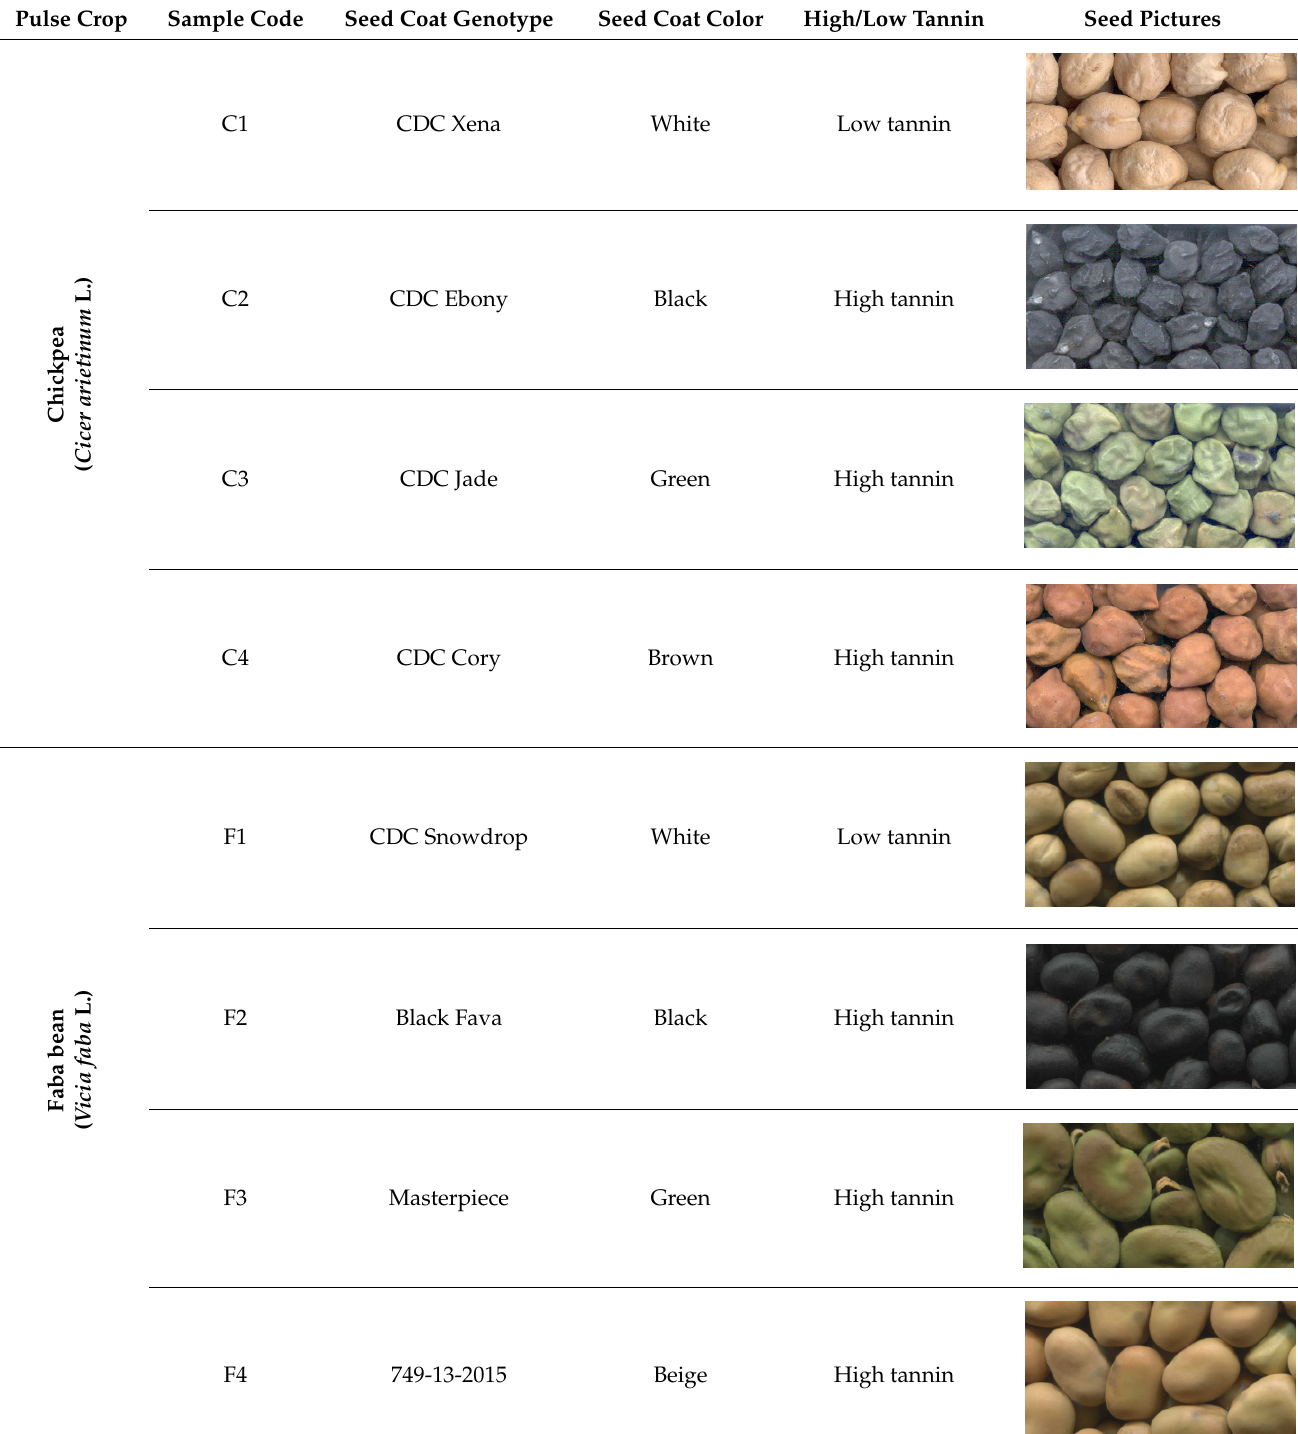
Table 3. Detailed description of pulse crops genotypes used in this study.